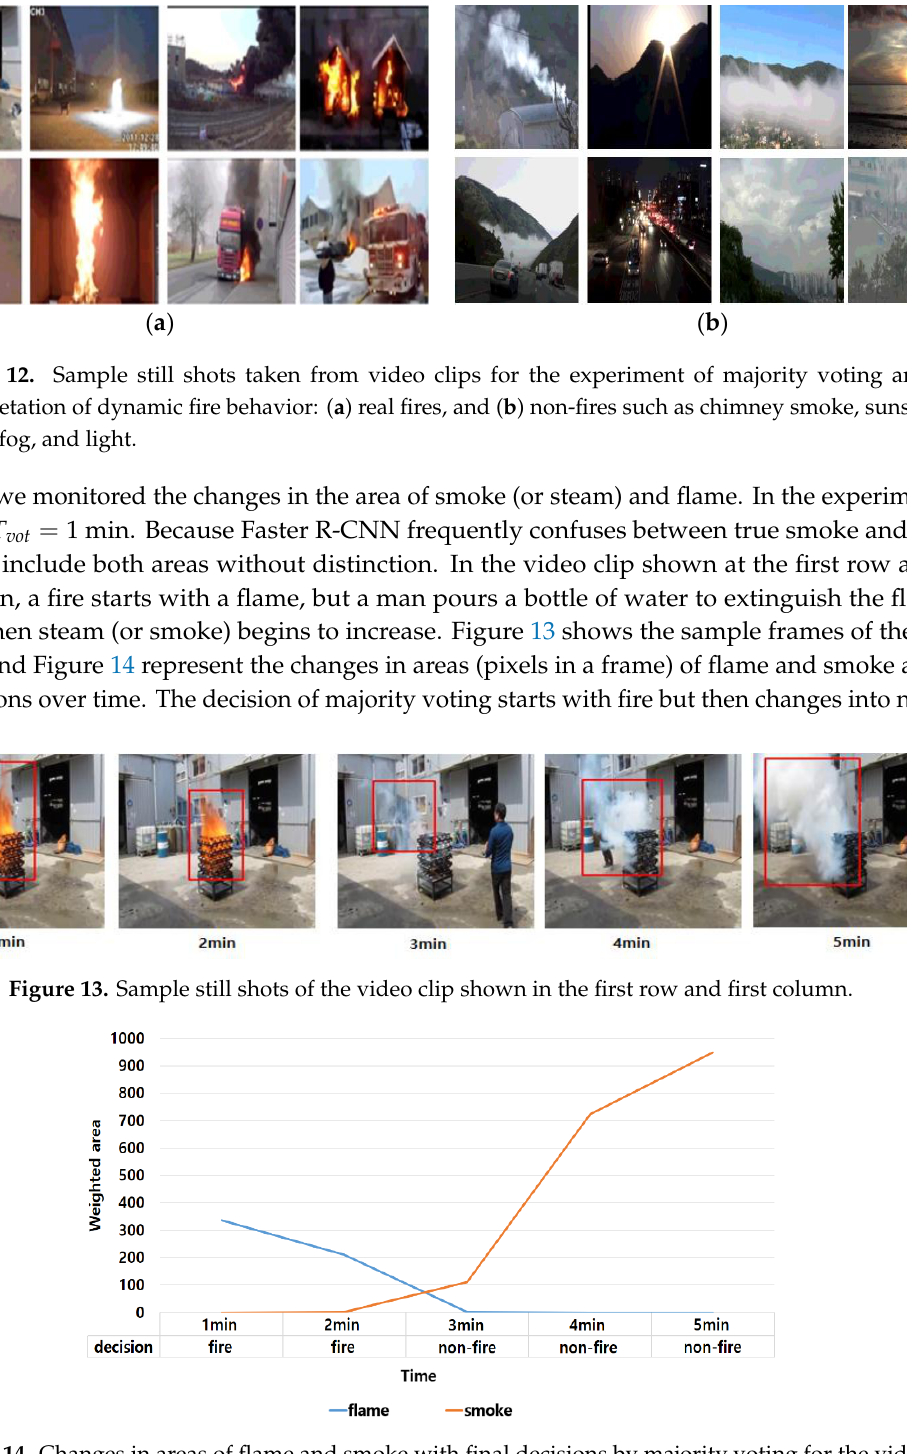
Figure 14. Changes in areas of flame and smoke with final decisions by majority voting for the video clip of Figure 13.